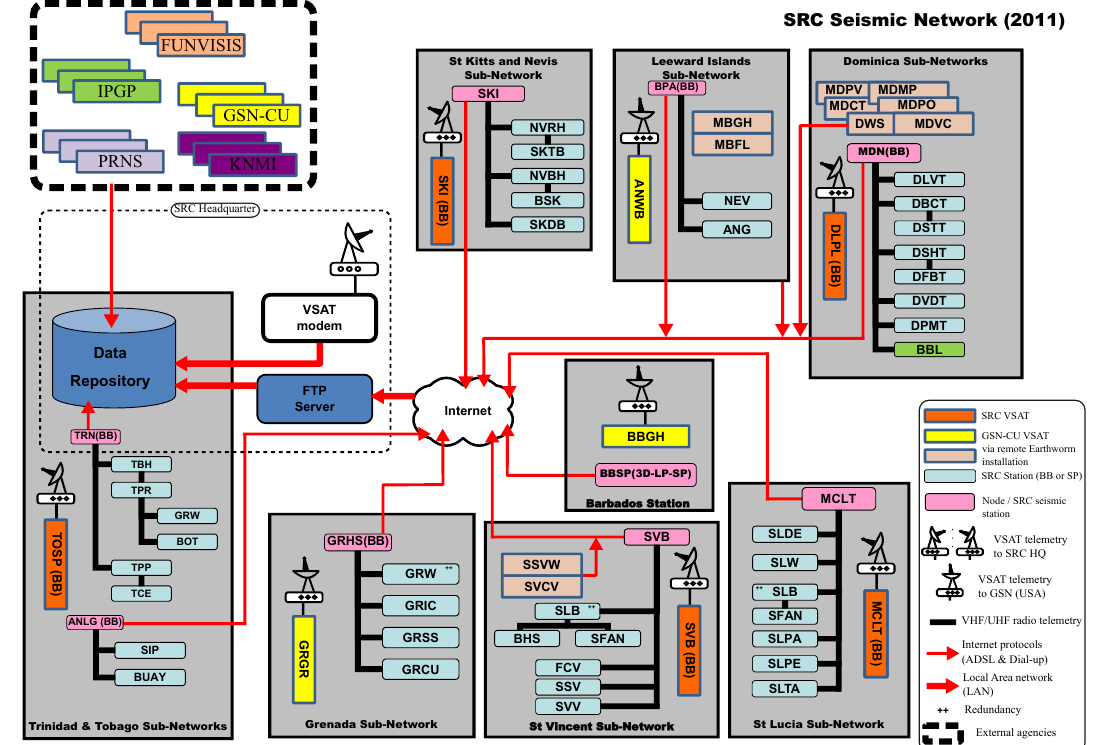
Figure 8. Architecture of the SRC seismic network by 2011. Asterix refers to the replacement of old single-component short period analogue instruments by three-component seismometers (short period, SP, or broadband, BB) at the following stations: MBGH, MBFL, MDPV, MDMP, MDCT, MDPO